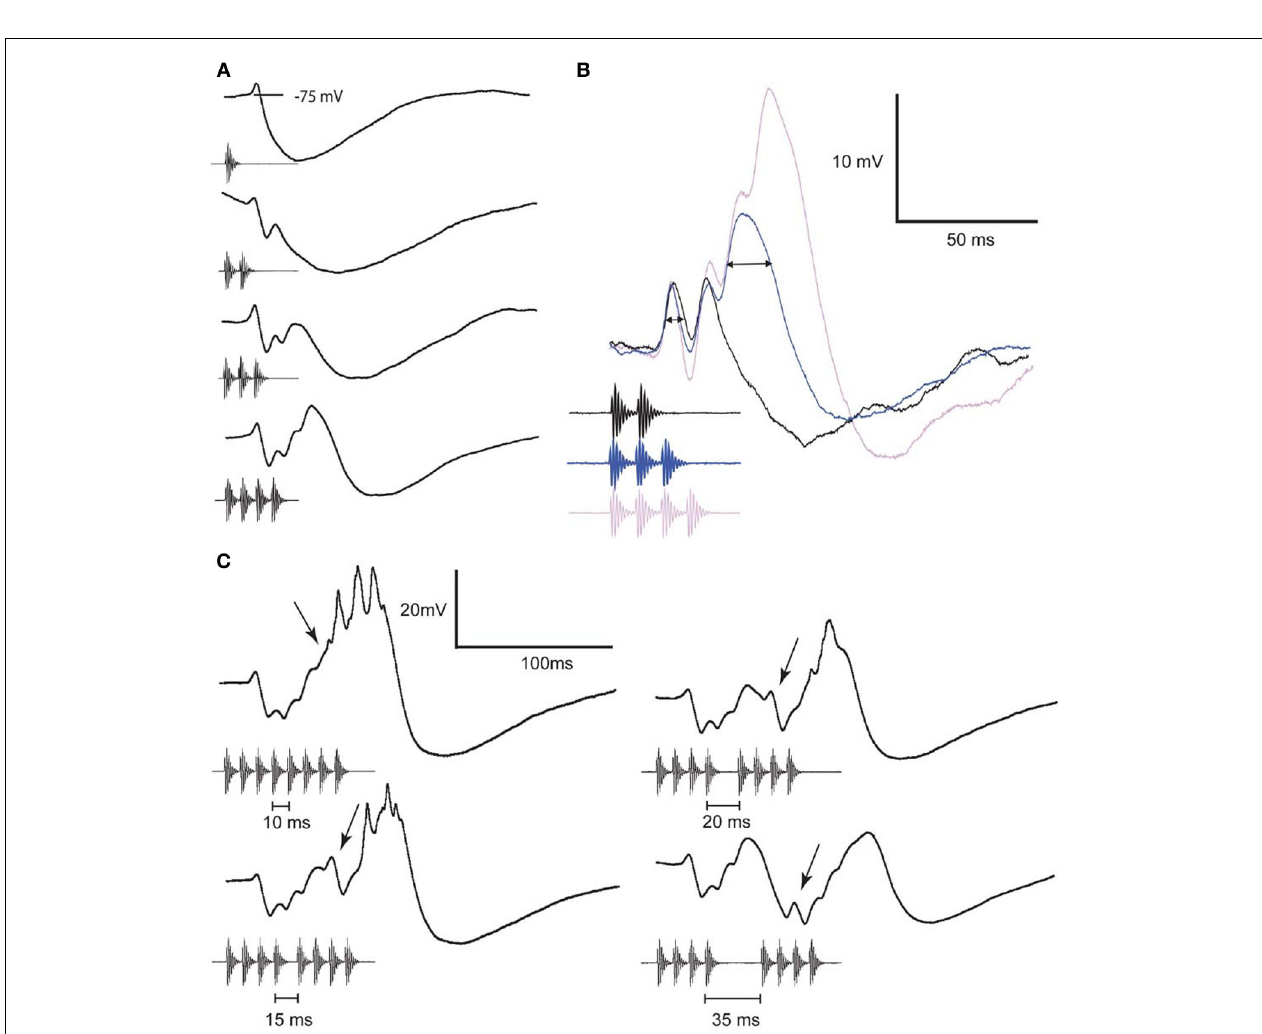
number of spikes over the number of stimulus presentations. Resting potential = − 68mV; carrier frequency = 300Hz; 66dB SPL. Adapted from (Rose et al., 2011).